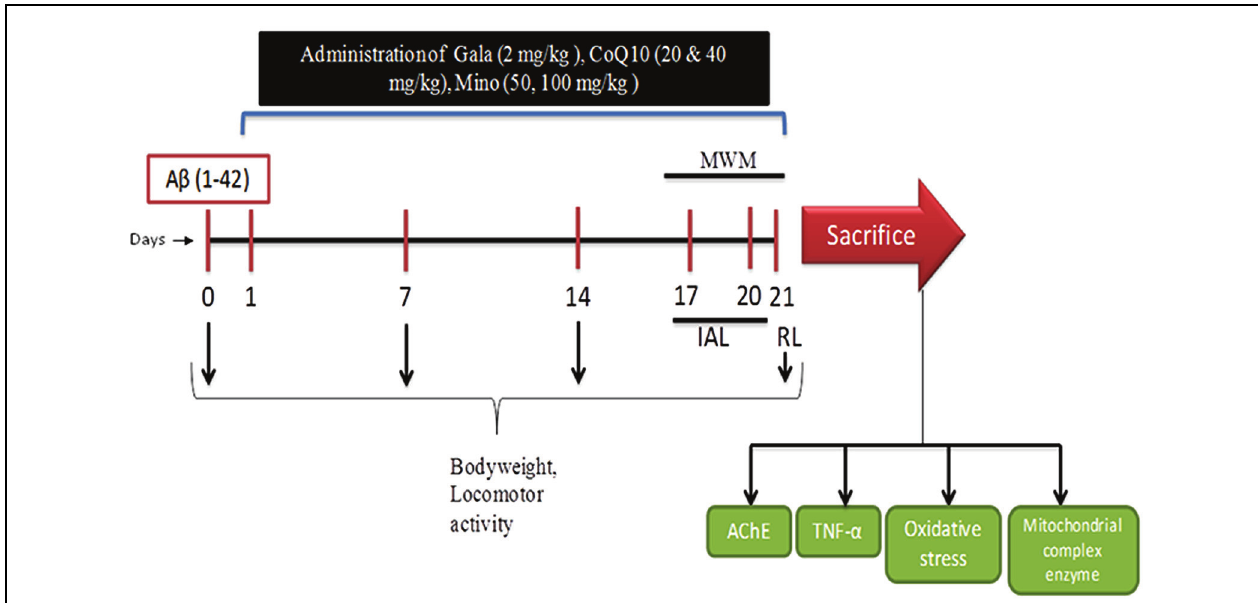
FIGURE 1 | Experimental Protocol (A β , amyloid beta; Gala, Galantamine; CoQ10, Coenzyme Q10; Mino, Minocycline; MWM, Morris water maze; IAL, initial acquired latency; RL, retention latency; AChE, acetylcholinesterase; TNF, Tumor Necrosis